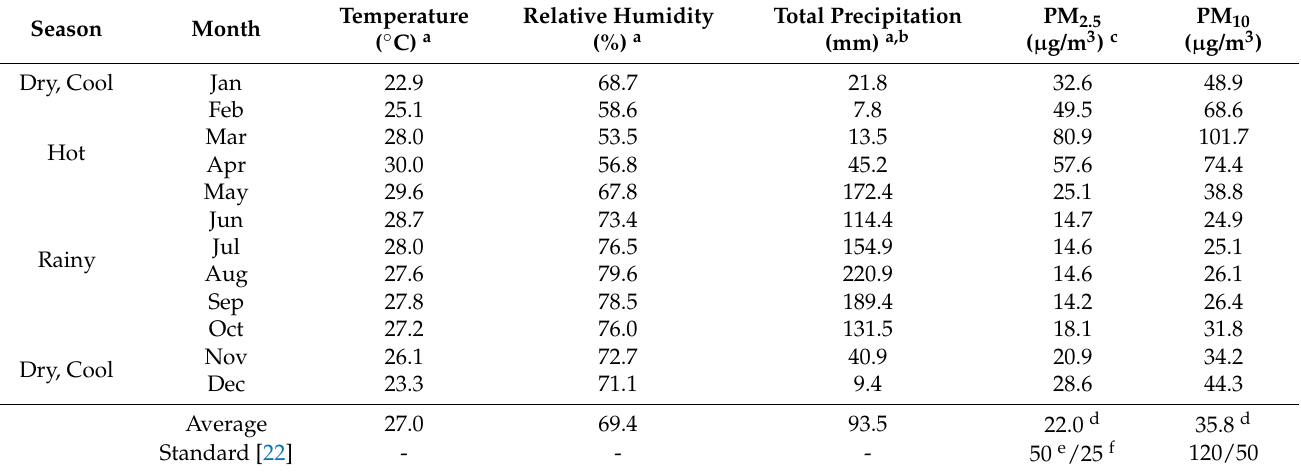
Table 1. Monthly average meteorological and air pollutant data in Chiang Mai from 2011 to